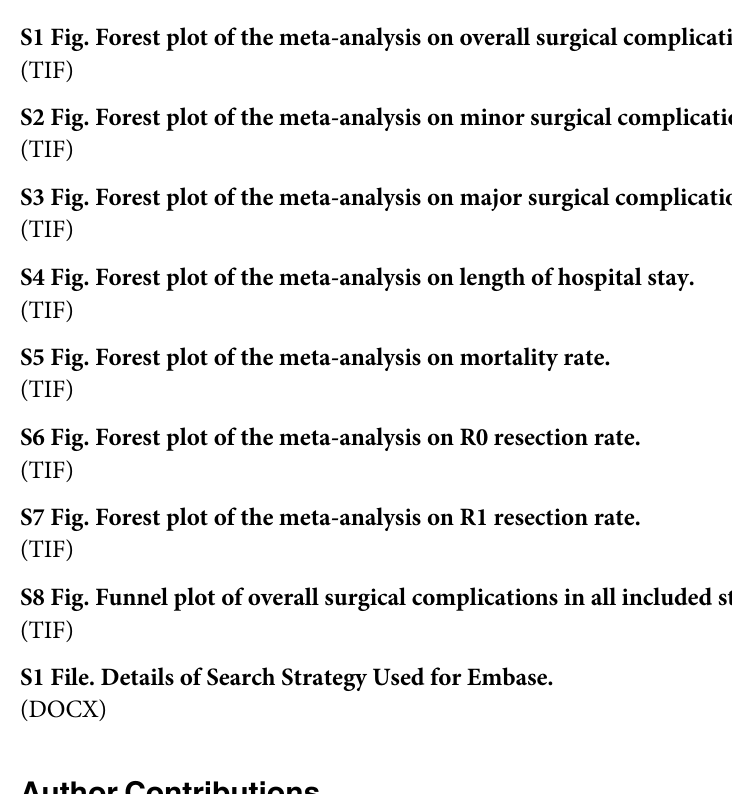
S1 Fig. Forest plot of the meta-analysis on overall surgical complications. (TIF) S2 Fig. Forest plot of the meta-analysis on minor surgical complications. (TIF) S3 Fig. Forest plot of the meta-analysis on major surgical complications. (TIF) S4 Fig. Forest plot of the meta-analysis on length of hospital stay. (TIF) S5 Fig. Forest plot of the meta-analysis on mortality rate. (TIF) S6 Fig. Forest plot of the meta-analysis on R0 resection rate. (TIF) S7 Fig. Forest plot of the meta-analysis on R1 resection rate. (TIF) S8 Fig. Funnel plot of overall surgical complications in all included studies. (TIF) S1 File. Details of Search Strategy Used for Embase.